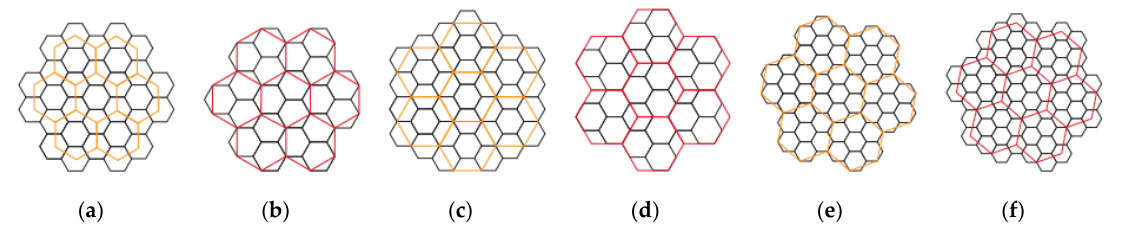
Figure 4. Centroid alignment and vertex alignment of three apertures for hexagonal grids (shown in orange and red, respectively): ( a ) and ( b ) are for aperture 3; ( c ) and ( d ) are for aperture 4; ( e ) and ( f ) are for aperture 7 (source—cited from [24]).